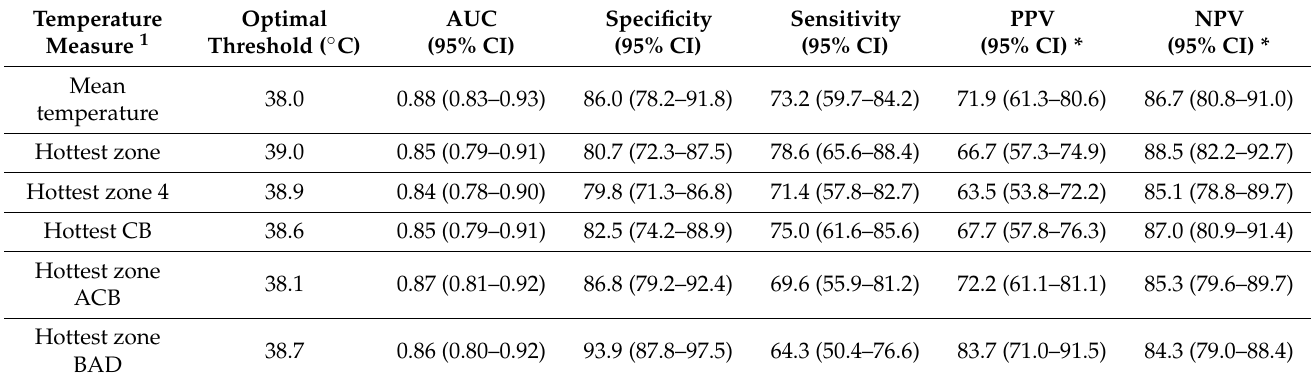
Table 8. Optimal cut-off points for skin foot temperature measurements (degrees centigrade)